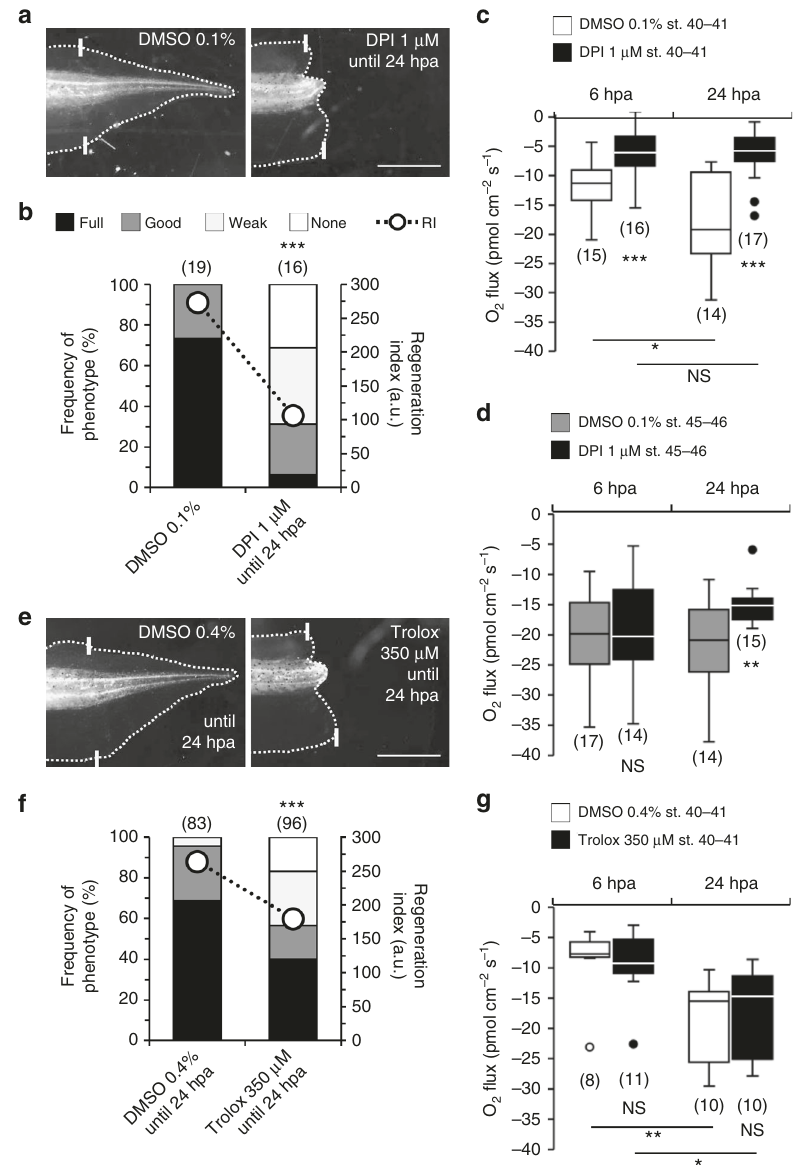
Fig. 3 Exogenous O 2 fuels ROS production that is necessary for regeneration. a – d O 2 in fl ux fuels ROS production in regenerative but not likely in refractory period tadpoles. a Representative tails at 7 dpa in vehicle-control and pharmacological treatment from tadpoles amputated at st. 40 – 41. b Qualitative and quantitative analyses of regeneration ef fi ciency for the different conditions tested. Most tadpoles from O 2 fl ux measurements. RI regeneration index. Stacked bars legend applies to f . O 2 fl ux measured in two different time-points in the bud of vehicle-control and pharmacological treatment from tadpoles amputated in regenerative c or refractory period d . e – g The magnitude of O 2 in fl ux is independent of ROS per se. e Representative tails at 7 dpa in vehicle- control and pharmacological treatment from tadpoles amputated at st. 40 – 41. f Qualitative and quantitative analyses of regeneration ef fi ciency for the different conditions tested. Tadpoles from O 2 fl ux measurements included in quanti fi cation. g O 2 fl ux measured in two different time-points in the bud of vehicle-control and pharmacological treatment from tadpoles amputated at st. 40 – 41. White solid lines: amputation plane; scale bar: 1 mm; a.u. arbitrary units. Statistical analyses were performed by Fisher ’ s exact test b , f , or unpaired Student ’ s t -test (both two-tailed p -value) c , d , g . Data are presented as median± min to max (with outliers). n biological replicates indicated in brackets. NS non-signi fi cant; * p < 0.05; ** p < 0.01; *** p <